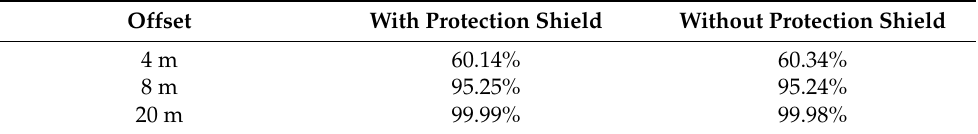
Figure 11. Results of settlement of the pilot tunnel through numerical analysis (point A). Table 5. Decreased rate of settlement at point B with an increase in separation distance between blasting point and protection